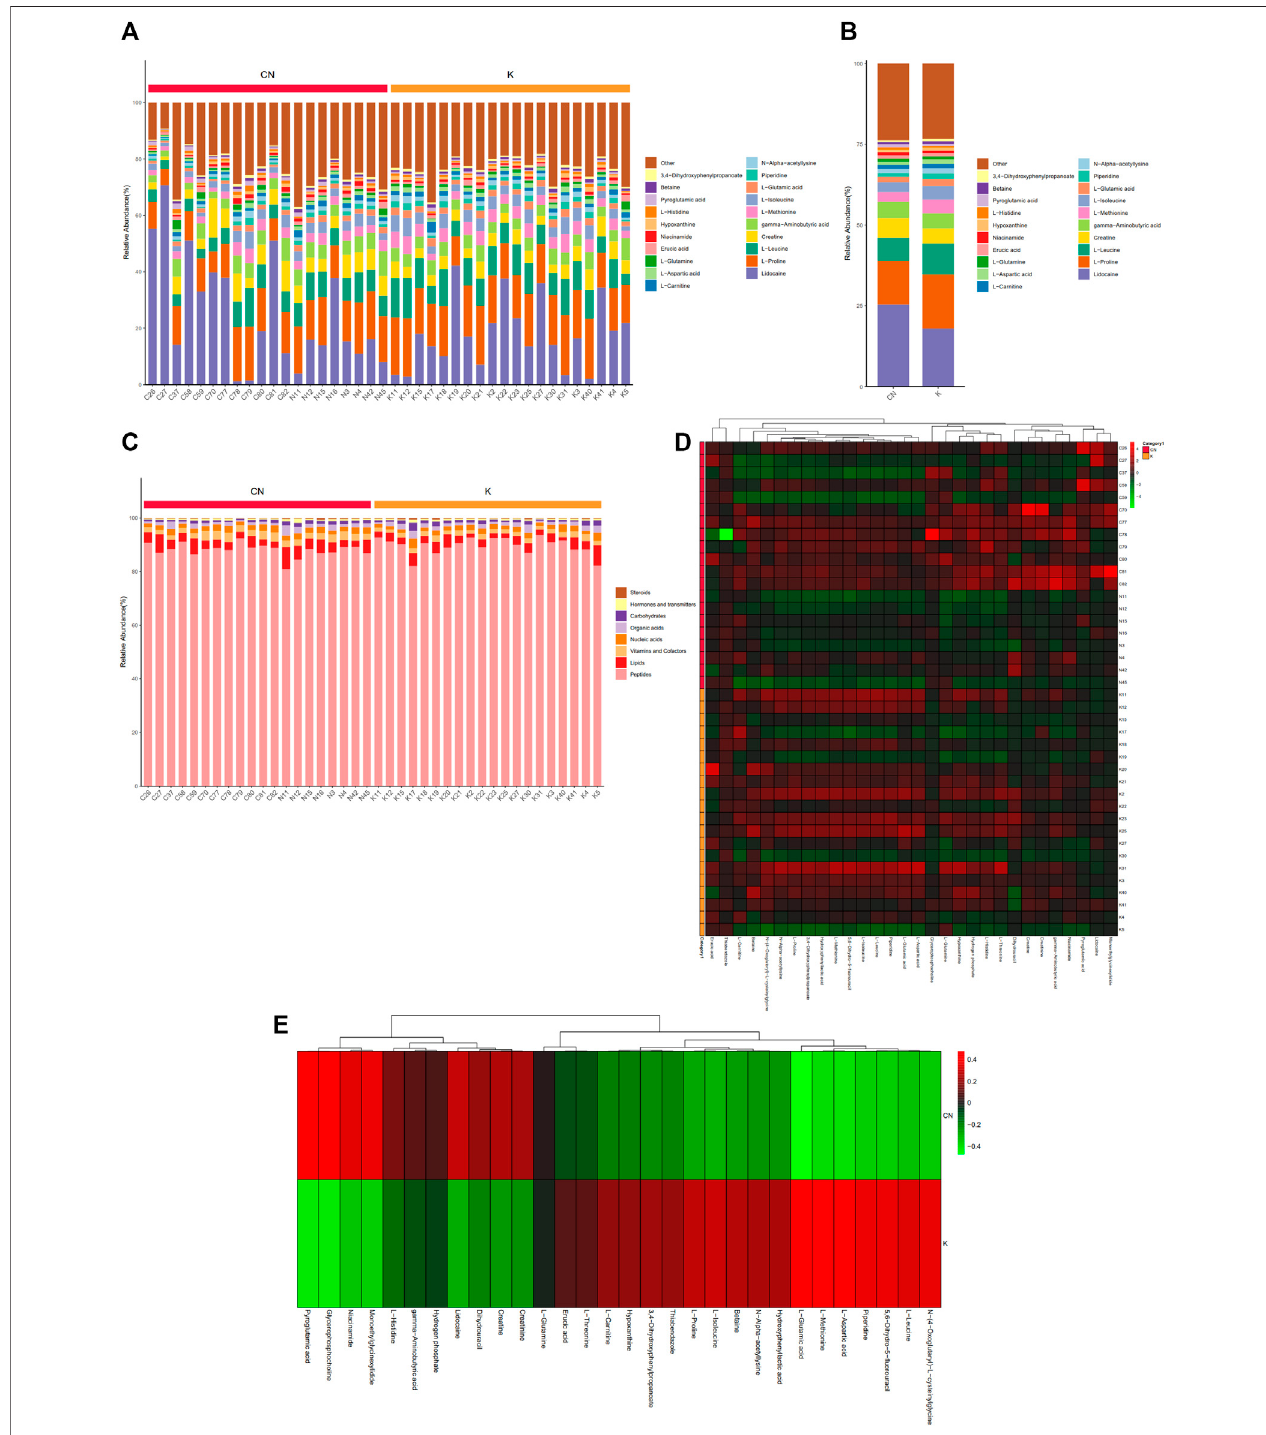
FIGURE3| Metabolitecontentstatistics. (A) Theabscissaisthesamplename,sortedaccordingtothegroupingorder,anddifferentgroupedsamplesaremarked with different colors. The ordinate represents the percentage content of each metabolite, and the order of the columns corresponding to the metabolites from top to bottom is consistent with the legend. (B) (C) The vertical axis is the sample name information and includes grouping information. The horizontal axis is metabolites. The cluster tree at the top of the fi gure is the similarity clustering of the metabolite distribution in each sample, the middle heatmap is the metabolite content heatmap, and the relationship between color and metabolite content (Z score) is shown in the upper right scale ruler. (D) The expression of metabolites between the two groups.